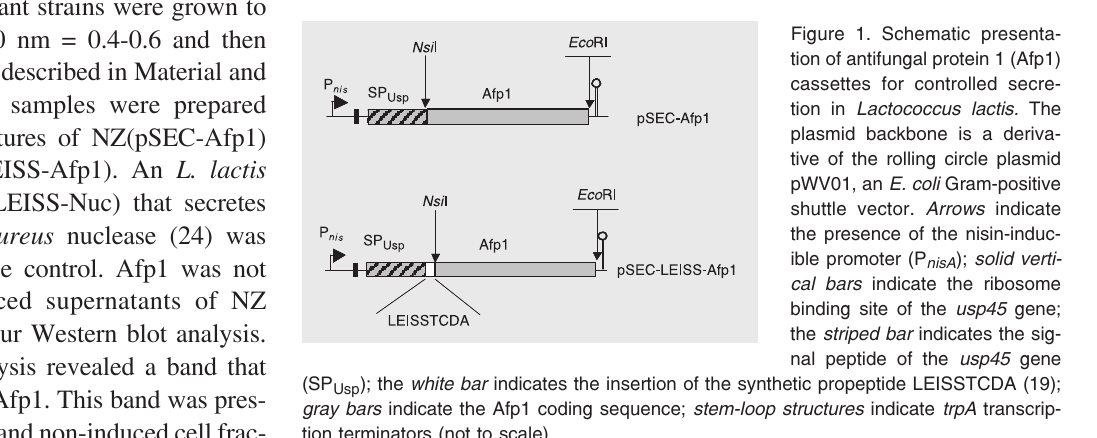
(SP Usp ); the white bar indicates the insertion of the synthetic propeptide LEISSTCDA (19); gray bars indicate the Afp1 coding sequence; stem-loop structures indicate trpA transcrip- tion terminators (not to